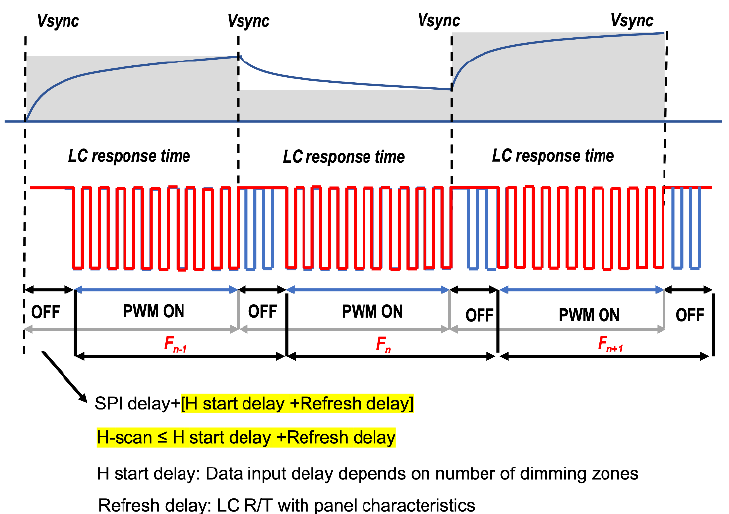
Figure 6. Comparison between traditional BFI, BLU blinking and proposed BLU scanning MPRT improvement method.